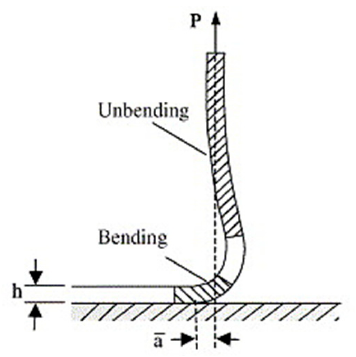
Figure 8. Peel test mechanism. (Adapted and reprinted with permission from [125], Elsevier 2005 copyright n. 4710150365138).